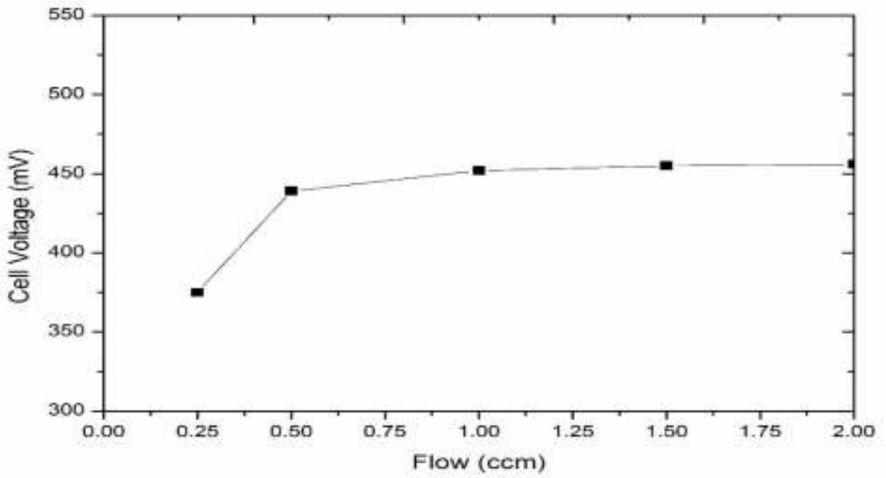
Figure 3. E ff ect of methanol flowrate.